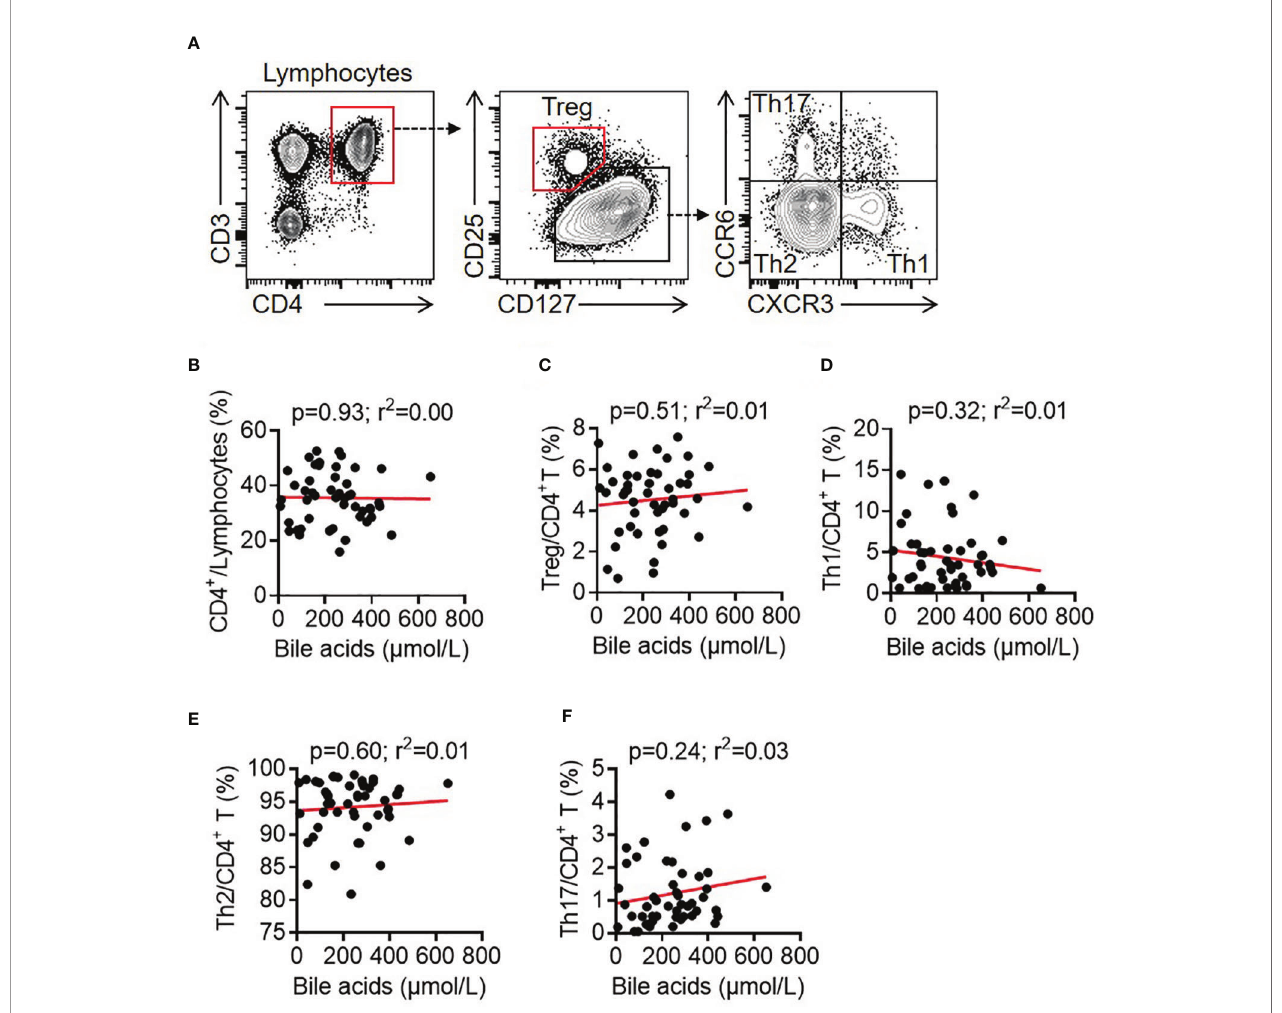
FIGURE 3 | Correlation between bile acids and T cells in BA children. (A) Representative FACS dots of CD4 + T (CD3 + CD4 + ), Treg cells (CD3 + CD4 + CD25 + CD127 - ), Th1 cells (CD3 + CD4 + CXCR3 + CCR6 - ), Th2 cells (CD3 + CD4 + CXCR3 - CCR6 - ), and Th17 cells (CD3 + CD4 + CXCR3 - CCR6 + ) in the PBMCs of patients with BA. (B – F) Correlation between bile acids and CD4 + T cells, Treg cells, Th1 cells, Th2 cells and Th17 cells in the PBMCs of patients with